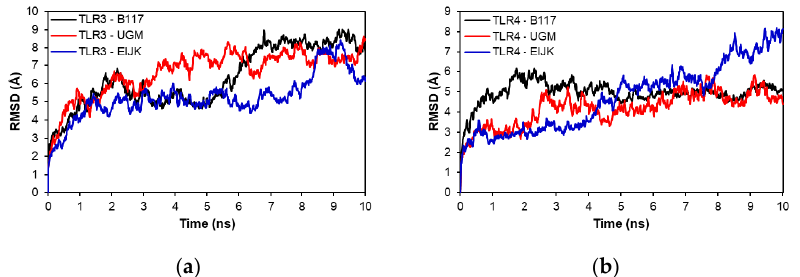
Figure 6. RMSD of TLR-3 ( a ) and TLR-4 ( b ) complexes.